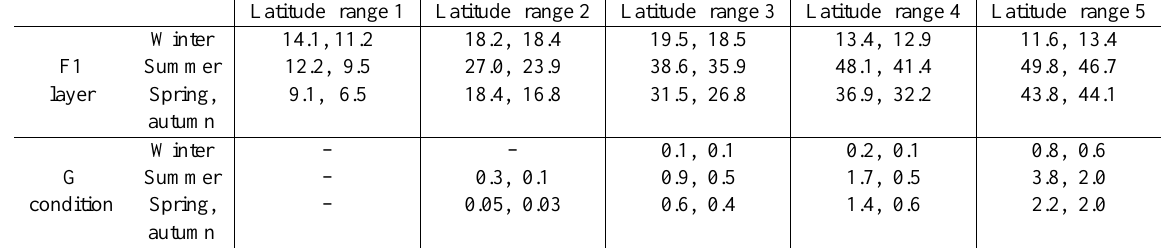
Table 1. Average values of F1-layer and G condition percentage occurrences in latitude ranges 1–5 during the winter, summer, and spring and autumn months for the first (first number) and second (second number) half of the day for χ ≤ 90